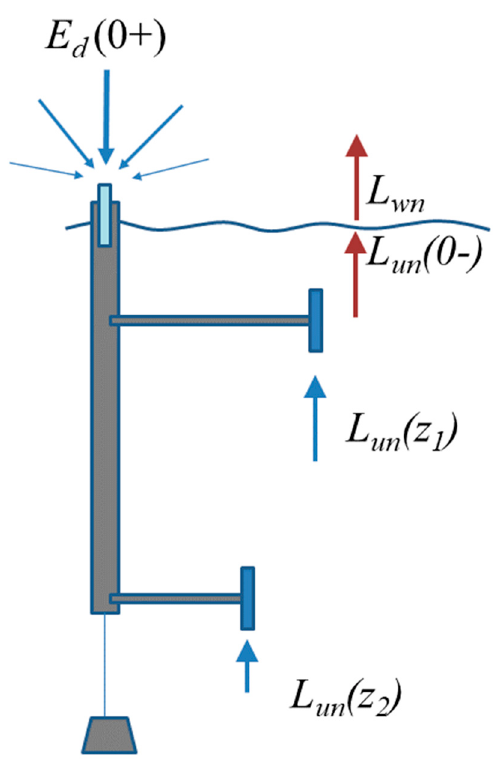
Figure 3. Schematic of fixed-depth underwater measurements.